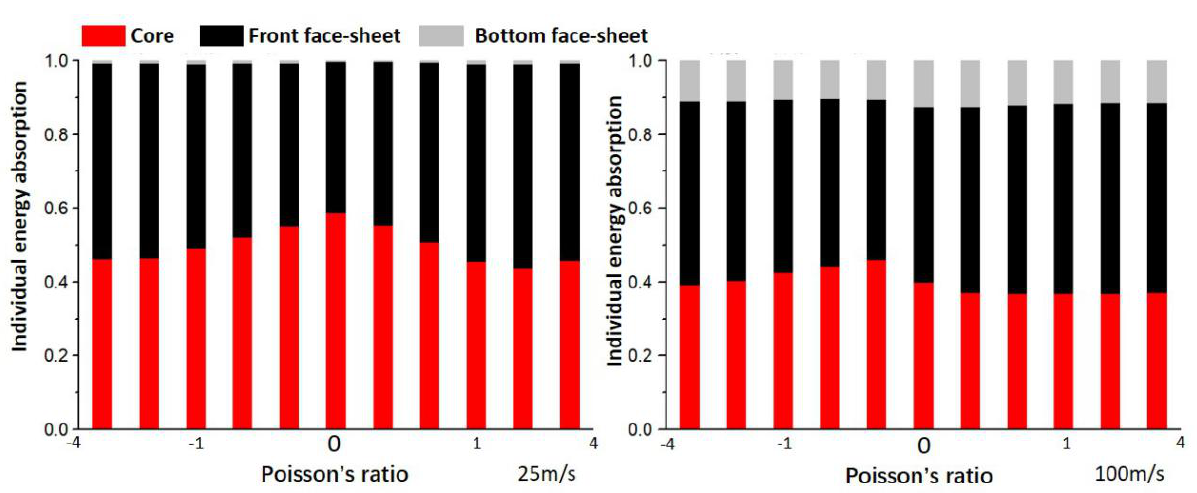
Figure 13: Individual energy absorption of face-sheets and honeycomb